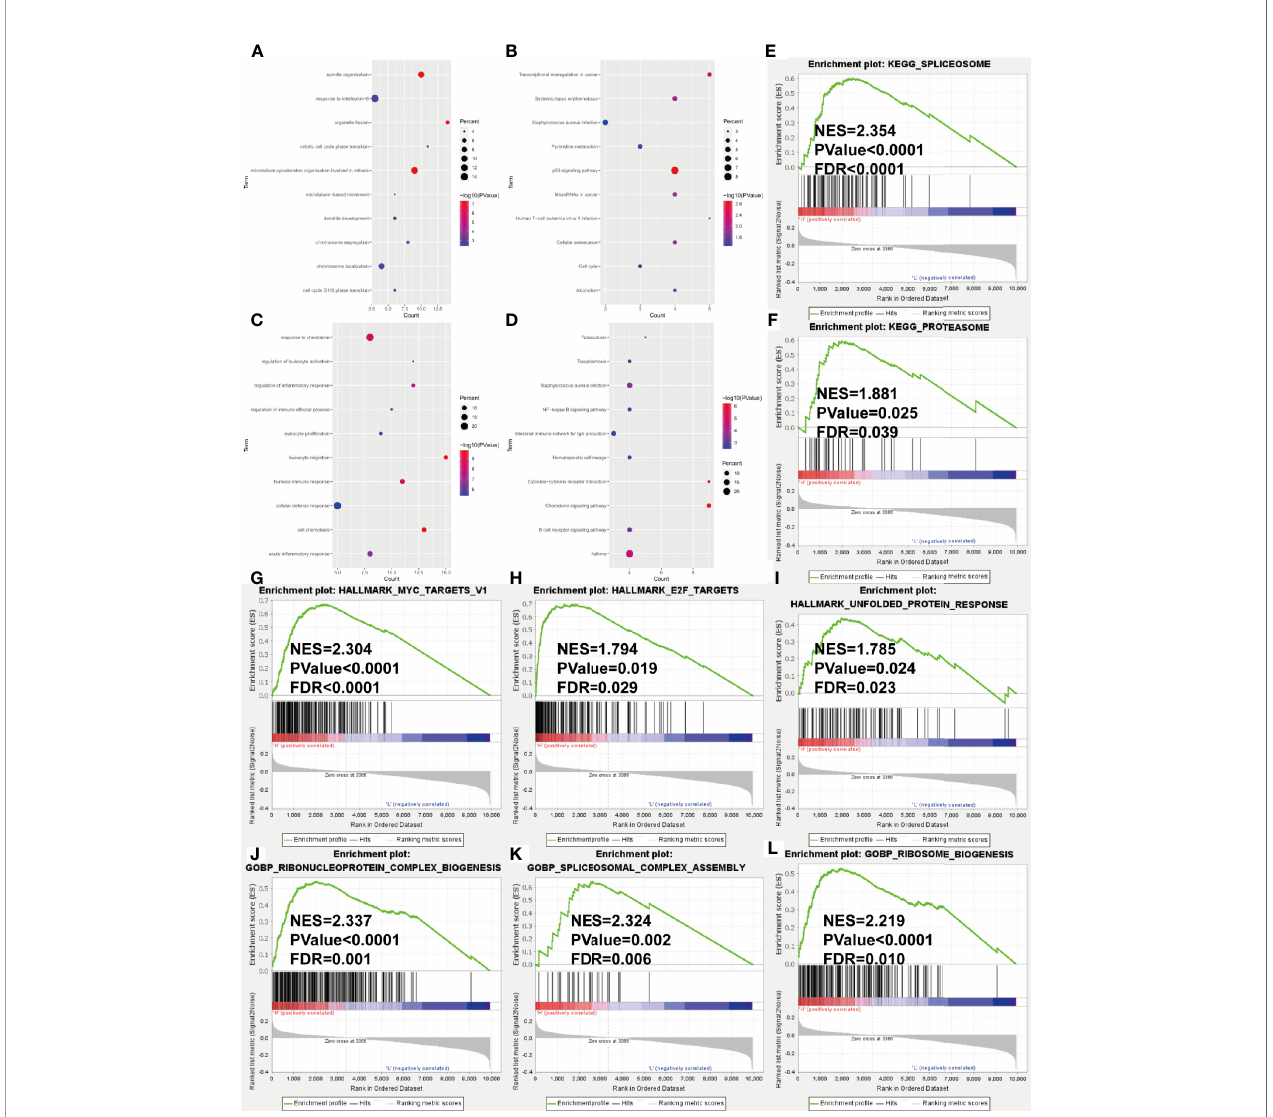
FIGURE 6 | Gene ontology and KEGG pathway enrichment analysis of DEGs in GSE24080 dataset grouped by risk score level. (A – D) Bubble diagrams show the signi fi cantly enriched gene ontology biological process (GOBP) and KEGG pathway terms of upregulated DEGs (A, B) and downregulated DEGs (C, D) . (E – L) GSEA results of KEGG gene set (E, F) , HALLMARK gene set (G – I) and GOBP gene set (J – L) . NES, normalized enrichment score; FDR, false discovery